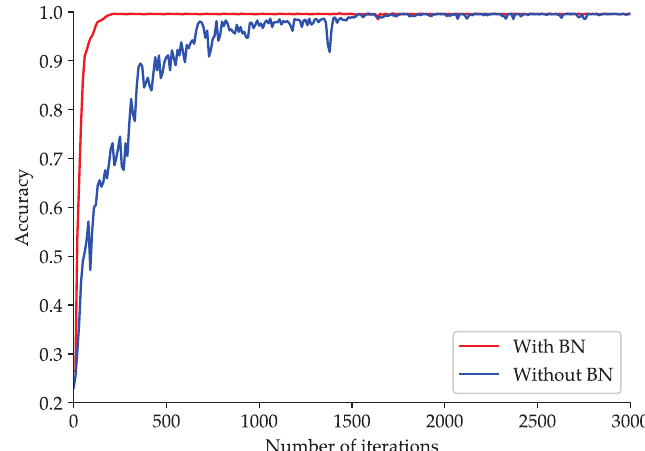
Figure 11. Accuracy curve obtained during the training processes of the improved 2D LeNet-5 network with BN and that without